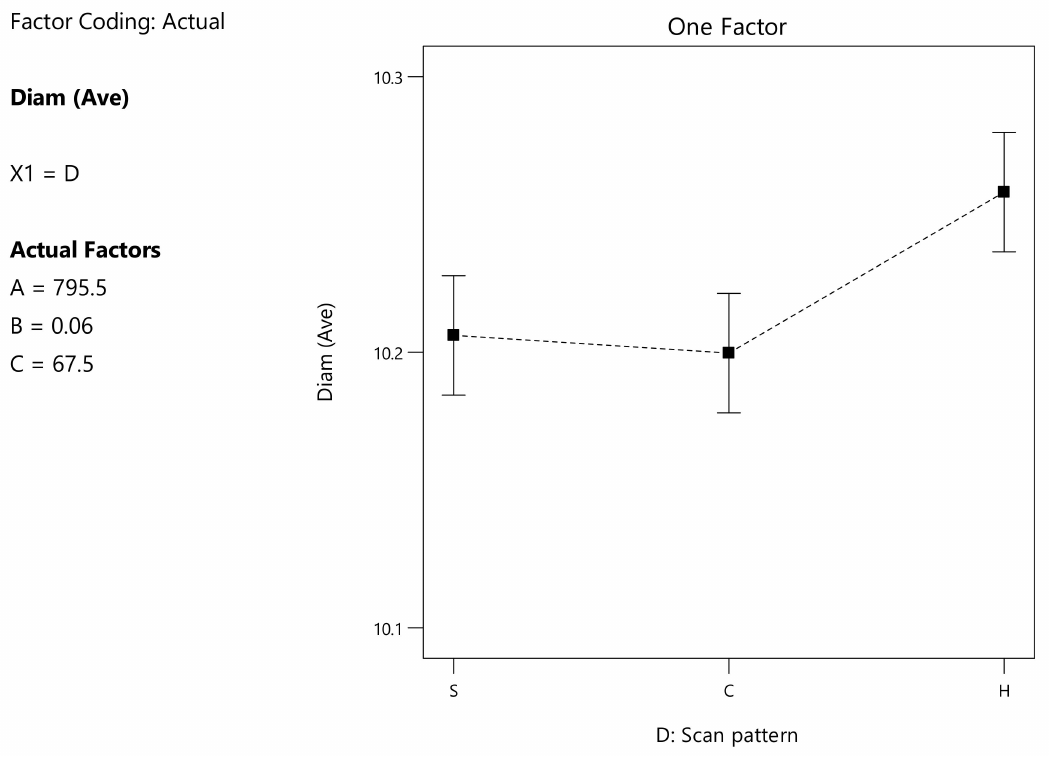
Figure 10. Influence of the scanning strategy on the external dimensions (mm) of the